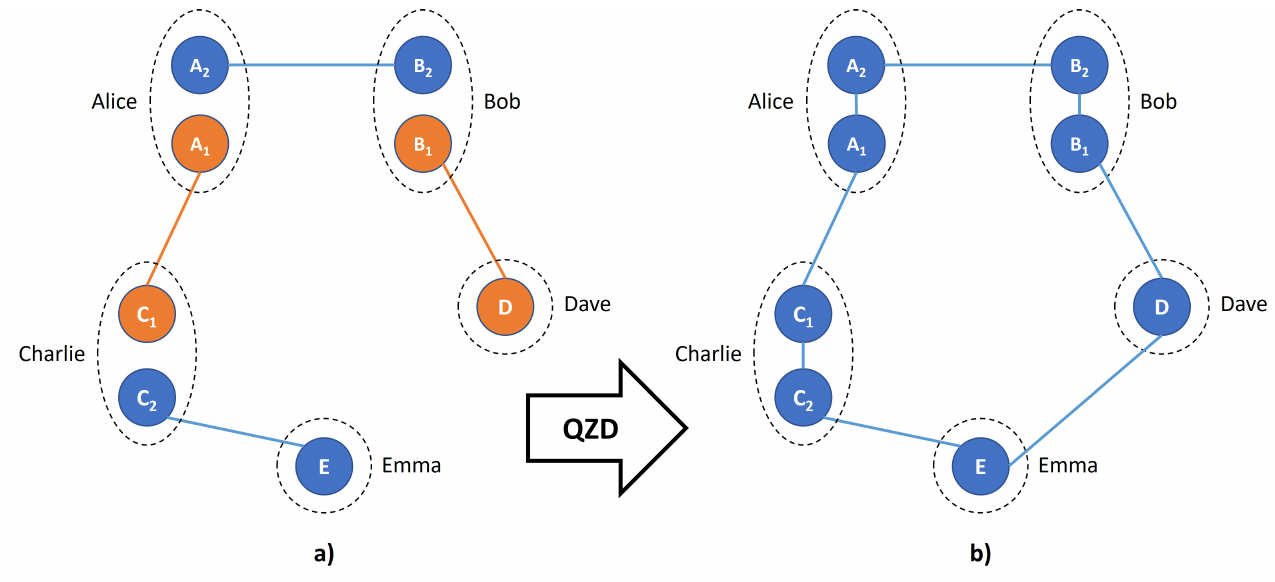
Figure 4. Logarithmic negativity of ρ DE after the implementation of quantum Zeno dynamics with n ) ≈ 0.8 for n = 3345, showing the superactivation iterations. The numerical simulation yields LN ( ρ n DE of bound entanglement of the initial ρ A state following the scenario in Figure 1 but 1 A 2 B 1 B 2 C 1 C 2 DE without requiring quantum state teleportations or Bell measurements.